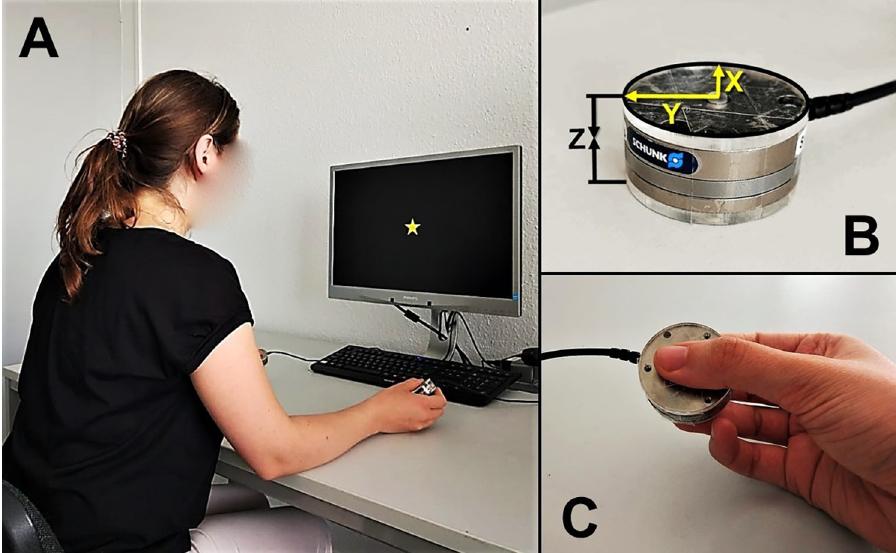
Fig 1. Experimental setup and equipment. Panel A. Bimanual force recording setup. Panel B. Grip force sensor (X– longitudinal, Y–radial, Z–compression forces). C. The way participants held the sensors (around 45˚ relative to the table surface, not strictly controlled). Adapted image from Miklashevsky et al. [15, Fig